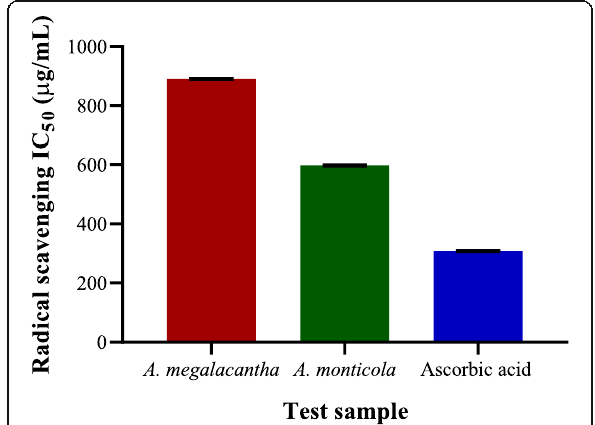
Fig. 5 The IC 50 values of leaves latexes of A. megalacantha and A. monticola against DPPH